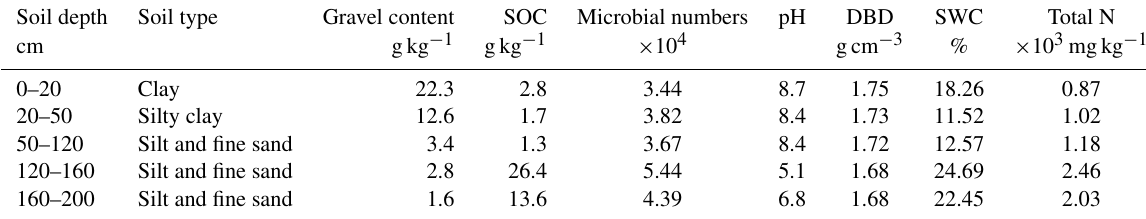
Figure 1. Geographic location of the study site. (a) Map of China’s permafrost distribution, and the red box marks the approximate location of the Qinghai–Tibet Plateau. (b) The study site location and meteorological stations along the Qinghai–Tibet railway. (c) Photo showing the study site’s topography and physiognomy. The small red flag in (c) is the eddy covariance tower location. (d) Close-up shot of the LI- 7700 for methane measurement. Map boundary and location are approximate. Geographic features and the names do not imply any official endorsement or recognition. Table 1. Soil characteristics at the eddy covariance flux study